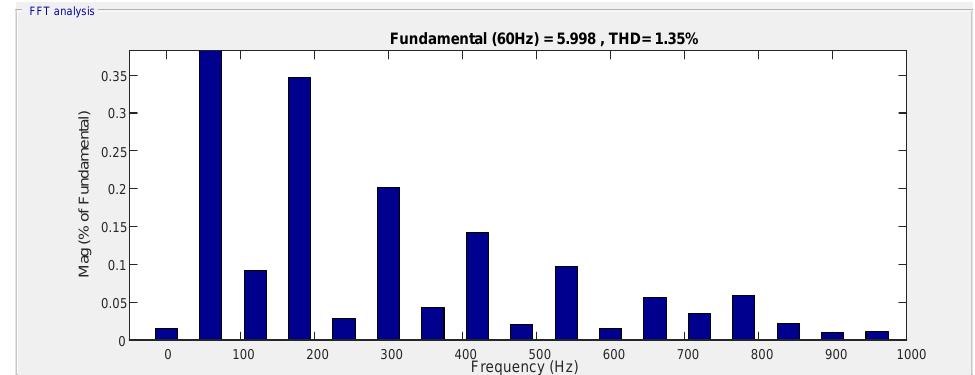
Figure 19. Grid current harmonic spectrum with the LCL filter.